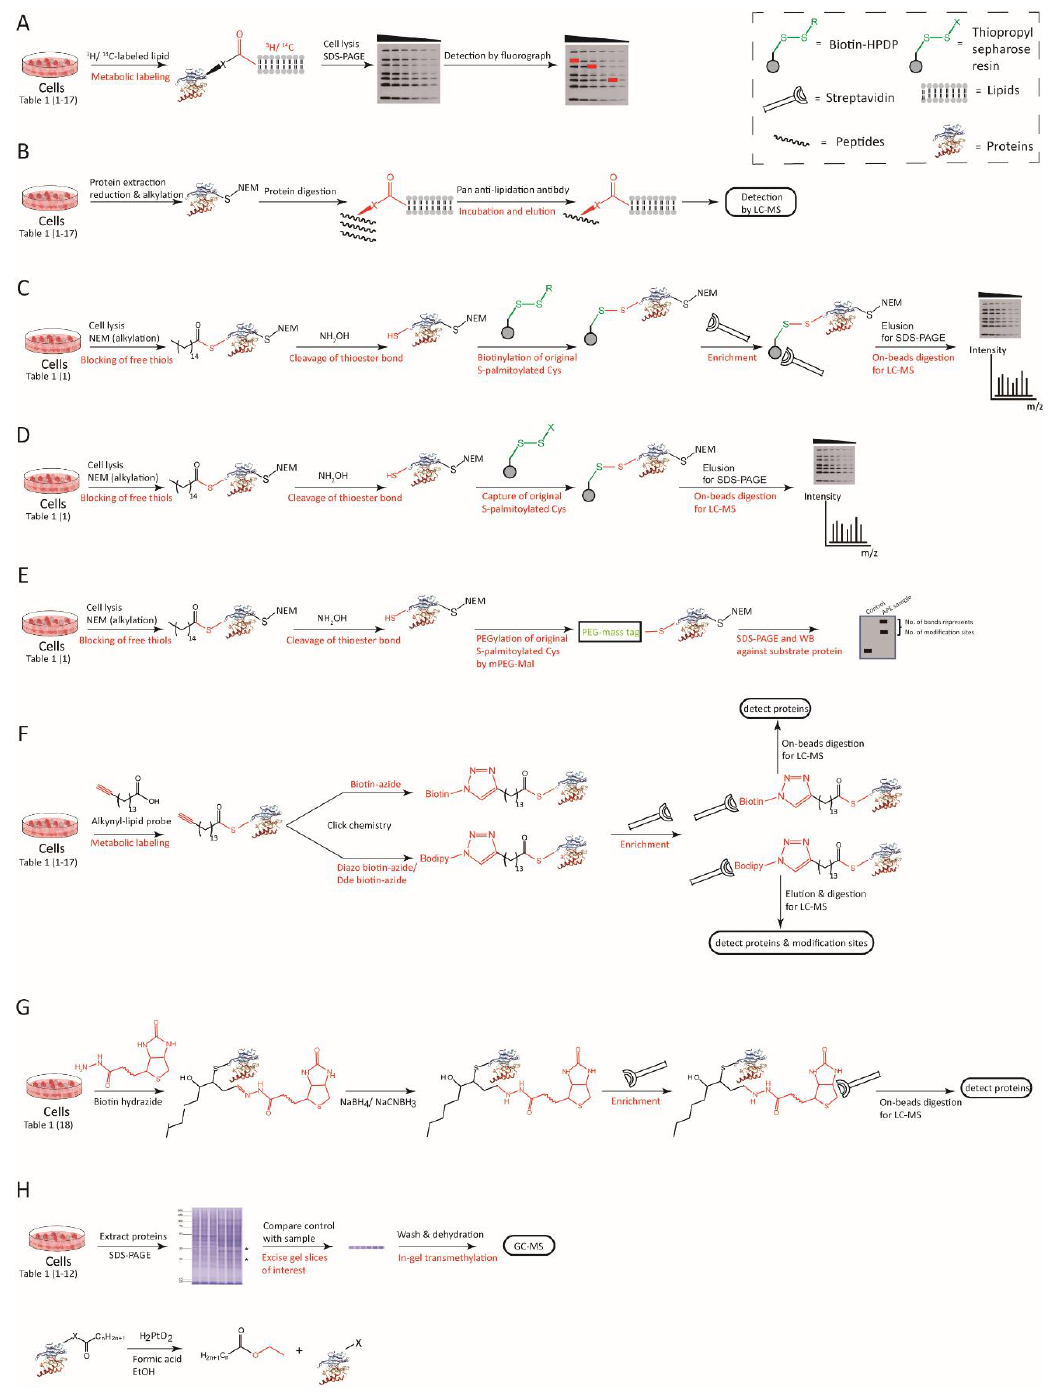
Figure 1. Various analytical methods to identify and characterize protein lipidations. ( A ) Radioactive isotope-labeling. Any type of protein lipidation can be identified using this method if the corresponding isotope-labeled lipid is available; ( B ) Antibody affinity enrichment. In general, any type of protein lipidation can be detected if a suitable pan-antibody is available; ( C – E ) ABE and similar methods. These methods are used for detecting S-pamitoylation; ( F ) Click chemistry. Protein lipidations that can react with specific alkynyl/azide-lipid probes can be identified; ( G ) Biotin hydrazide affinity capture. Only proteins containing carbonyl or aldehyde groups are suitable for this method to detect the LDE modifications; ( H ) Lipid esterification. Some saturated or unsaturated fatty acid moieties derived from protein acylations can be identified if the process of esterification on dissociative lipid (usually hydrolysis) is